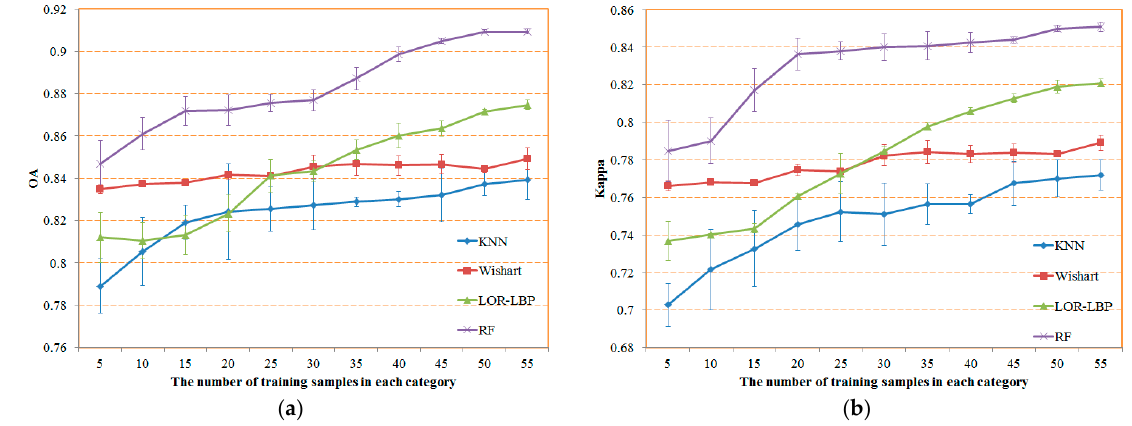
Figure 13. OA and Kappa curves with different numbers of training samples from the different